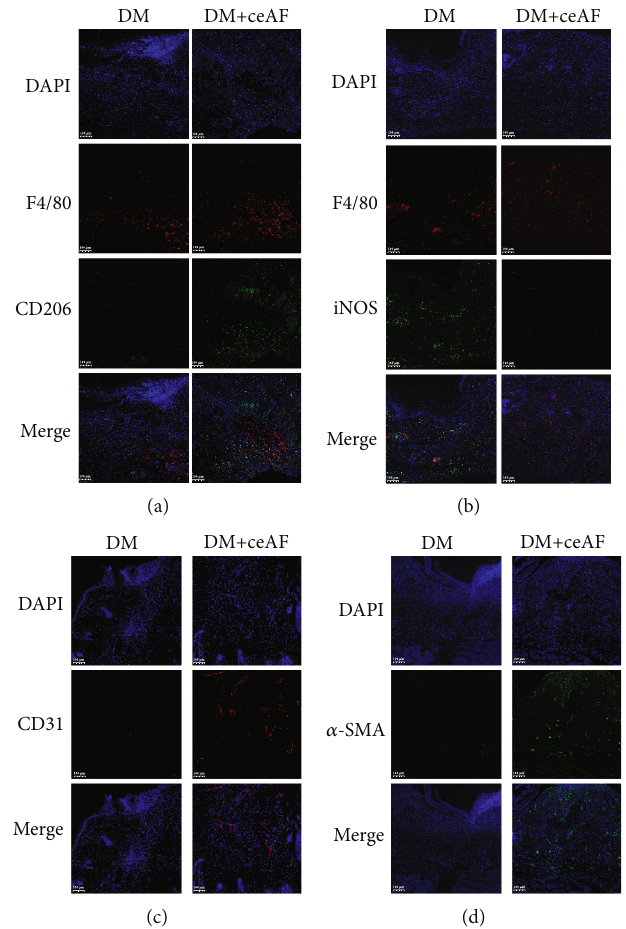
Figure 5: (a, b) Immuno fl uorescence assessment of CD206 + (green), iNOS + (green), and F4/80 + (red) cells in DM and DM+ceAF on day 5 postinjury. (c, d) Immuno fl uorescence analysis of CD31 + (red) and α -SMA + (green) cells in DM and DM+ceAF on day 10 postinjury. n = 6 , Scale bar: 100 μ